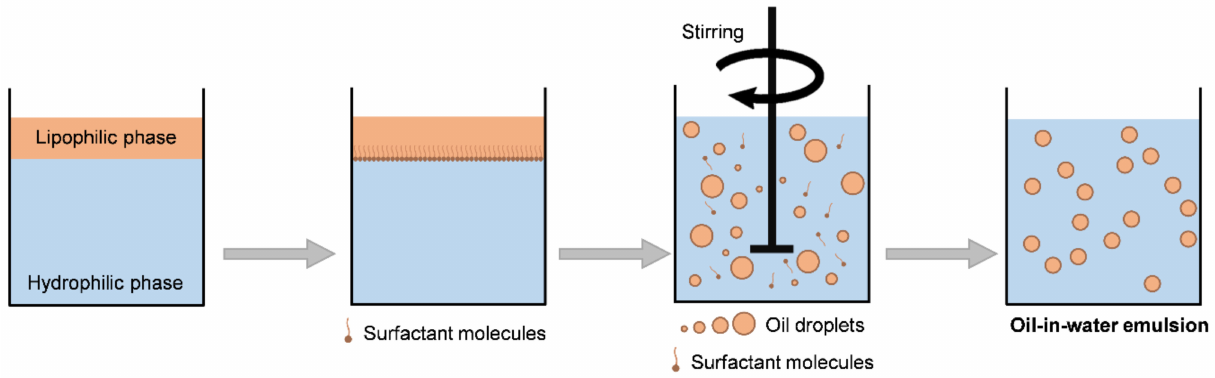
Figure 4. Production of an o/w